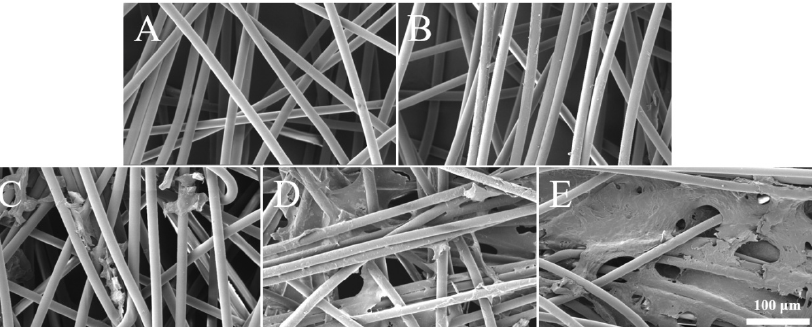
Figure 3 . SEM images of PLLA ( A ), PLLA-SH1 ( B ), PLLA-SH3 ( C ), PLLA-SH5 ( D ), and PLLA- SH10 ( E ).